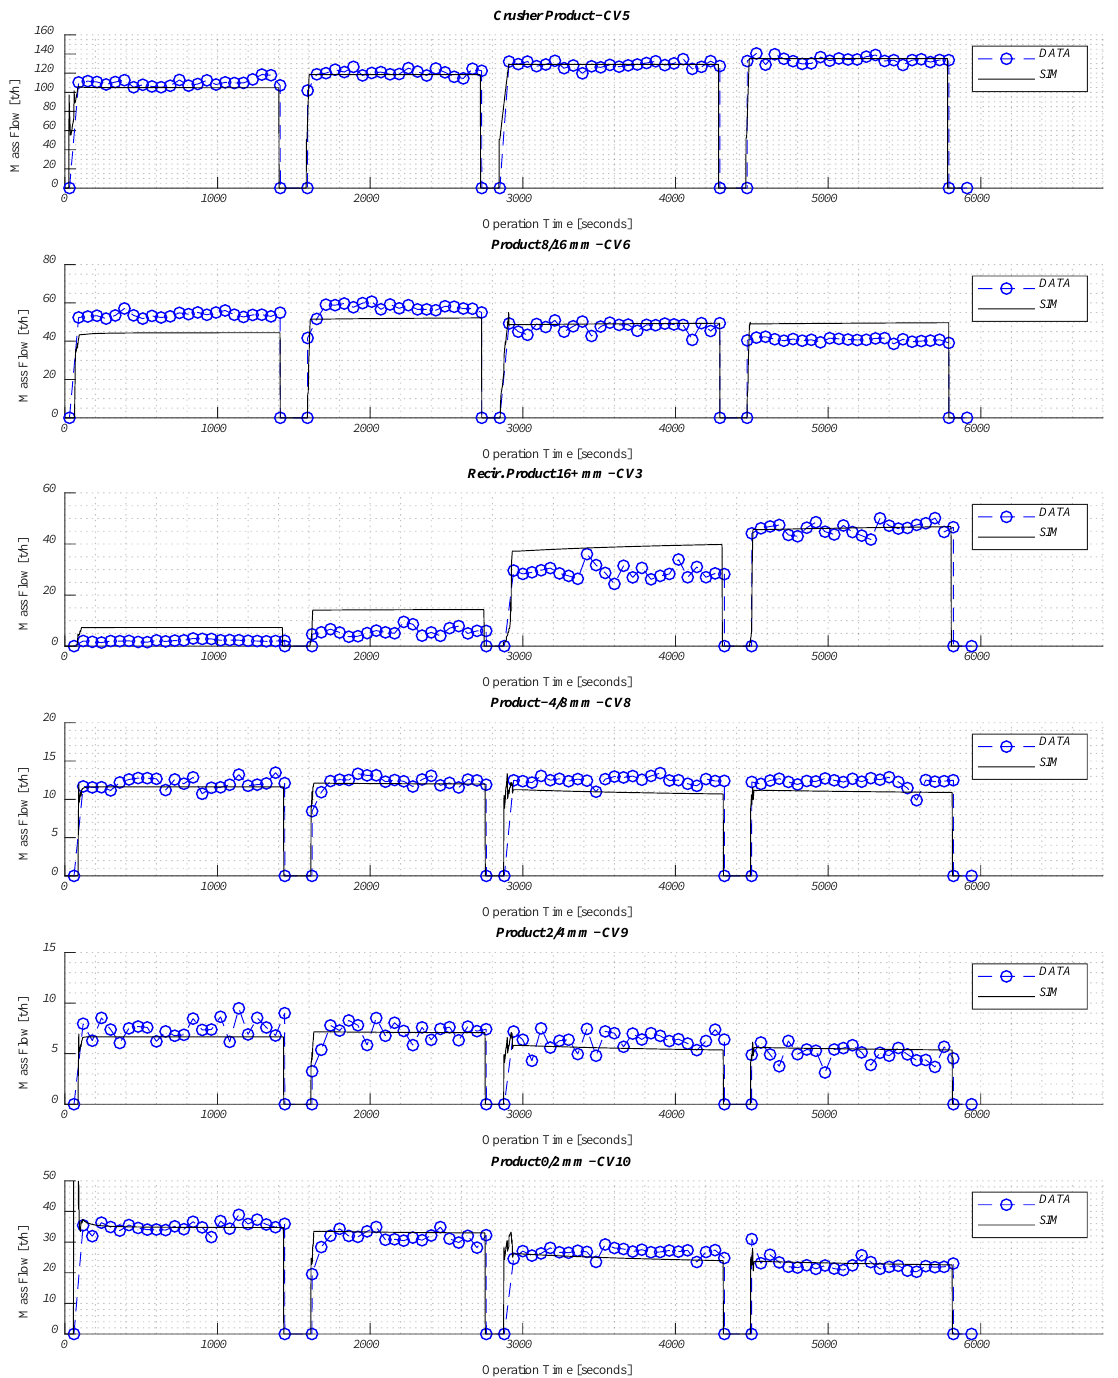
Figure 16. Dynamic simulation process results compared with the online production data for the four test conditions.